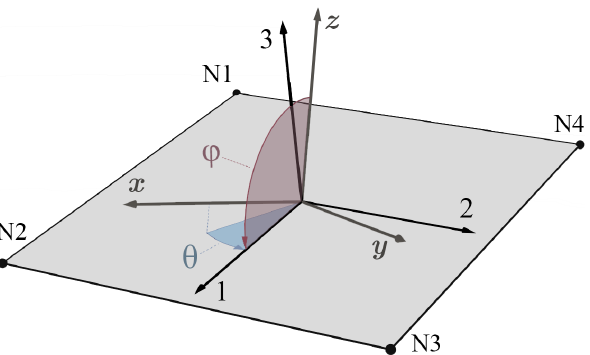
Figure 6. Shell element defined by nodes N1–N4 with local 123-system and azimuth θ as well as polar angle ϕ of the 1-direction with respect to the xyz